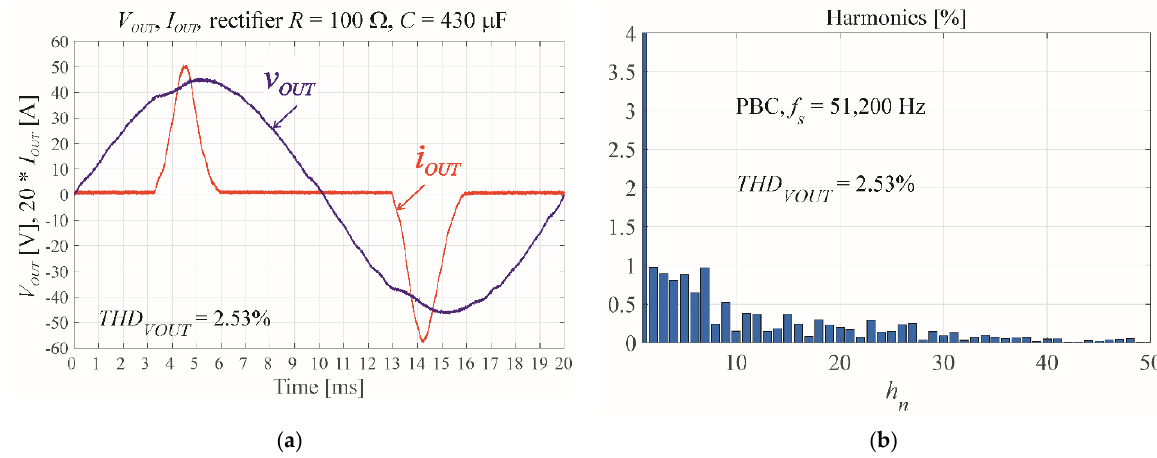
Figure 13. ( a ) The output voltage and current; ( b ) The harmonics analysis for the PBC with the experimentally adjusted border gains ( R i = 3, K v = 0.5, R i ’ = 10.98, K v ’ = 1.83) for f s = 51,200 Hz (RC load: R = 100 Ω , C = 430 μ F).